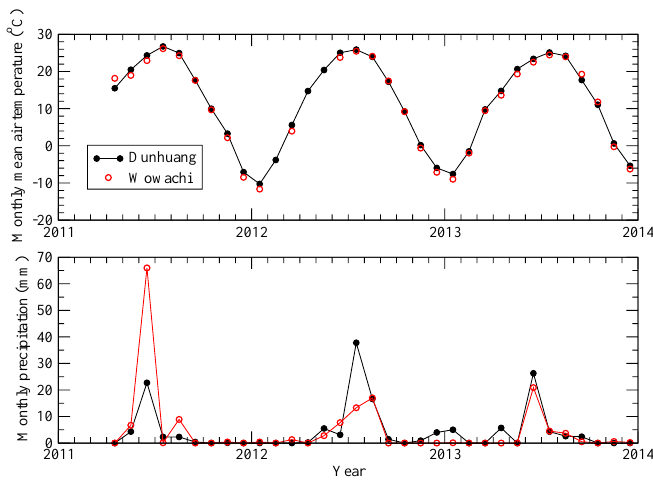
Figure 2. The time series plots of the monthly mean air temperatures and monthly precipitations measured at the Dunhuang weather station and the Wowachi automatic weather station.